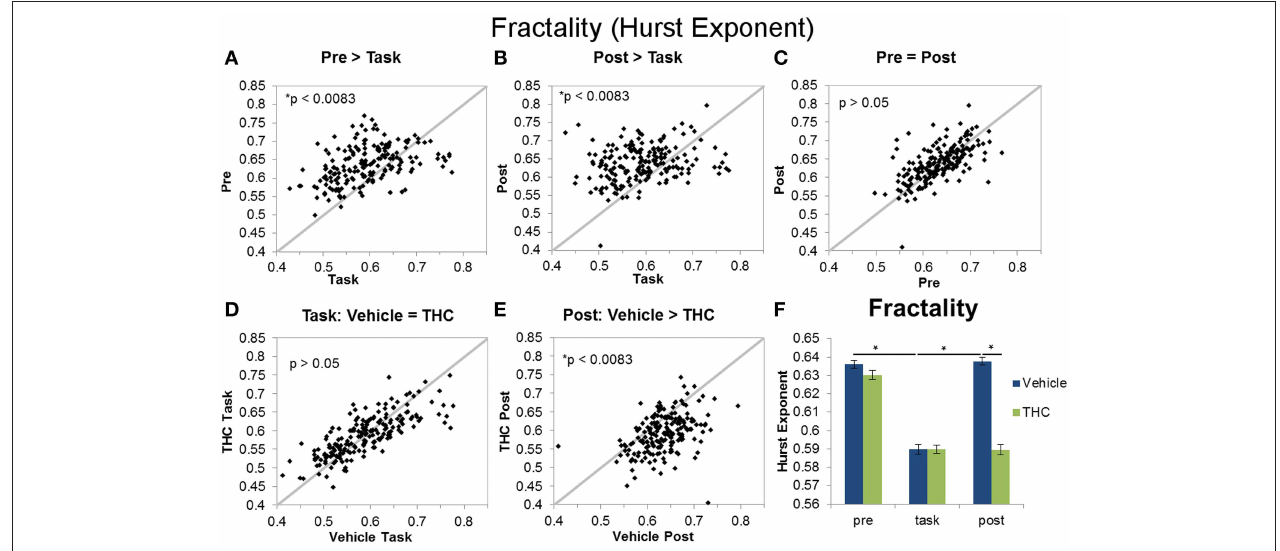
FIGURE 6 | Fractality (Hurst exponent) across recording phases and drug conditions. The scatter plots show each data point obtained by averaging the Hurst exponent for individual neurons over all recordings. All neurons included in the analysis were recorded for 2–8 days of vehicle and THC administration. Thick gray lines are y = x. Data points from vehicle only sessions are displayed in (A–C) . (A) Neurons exhibited greater Hurst exponents during the pre-task recordings compared to DNMS task recordings. (B) The Hurst exponent of ISIs was also greater during the post-task compared to task recordings. (C) Hurst exponents were similar during pre-task and post-task recordings. (D) THC had no effect on the Hurst exponent of neurons recorded during the DNMS task. (E) THC significantly reduced the Hurst exponent during post-task recordings. (F) Each bar was obtained by averaging Hurst exponent values from individual spike trains within specified recording phase and drug treatment combinations ( n = 771 –1004 neurons per group). Errors bars represent S.E.M. Statistical significance is designated by * indicating p < 0 . 0083 .